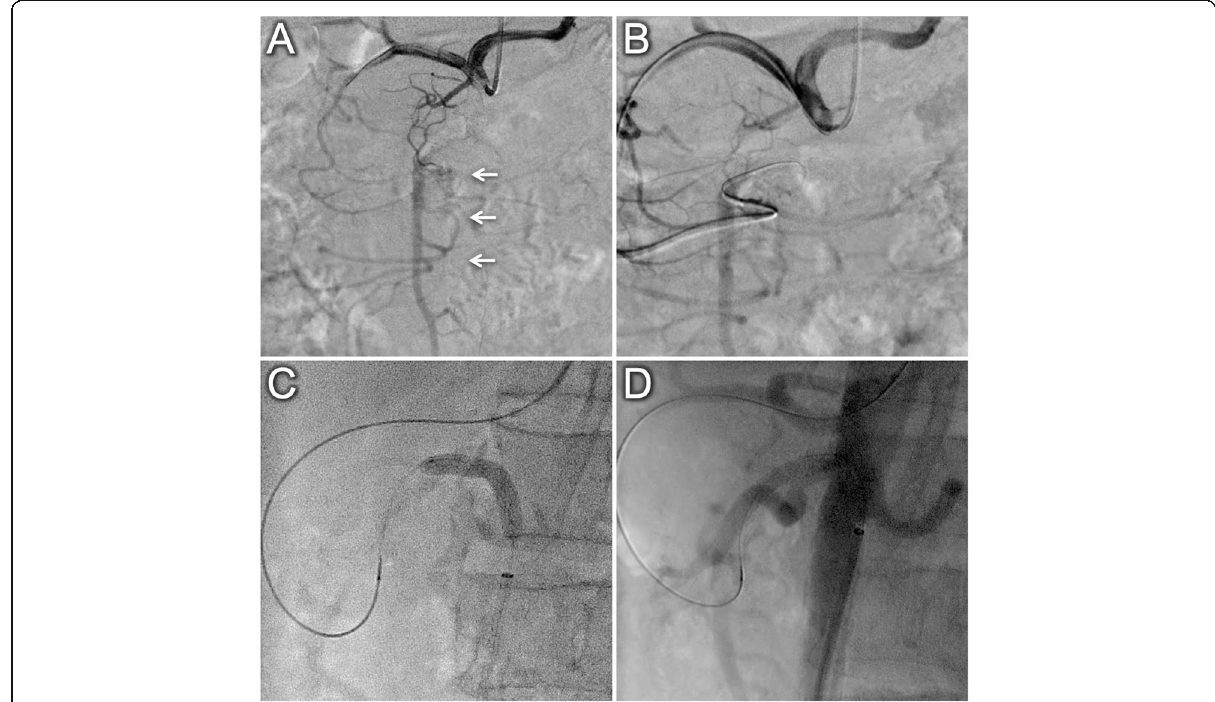
Fig. 2 Angiography and endovascular therapy. A , Digital subtraction angiography from the celiac artery showed collateral blood flow supplying to the superior mesenteric artery (SMA) (white arrows); however, did not show the pancreaticoduodenal arcade clearly. B , The Jupiter SFC guidewire with Corsair microcatheter reached the distal portion of the chronic total occlusion (CTO) in the SMA through the pancreaticoduodenal arcade as shown by computed tomography imaging. C , A 6.0 mm balloon was dilatated in the CTO. D , Angiography showed antegrade blood flow in the SMA after two balloon expandable